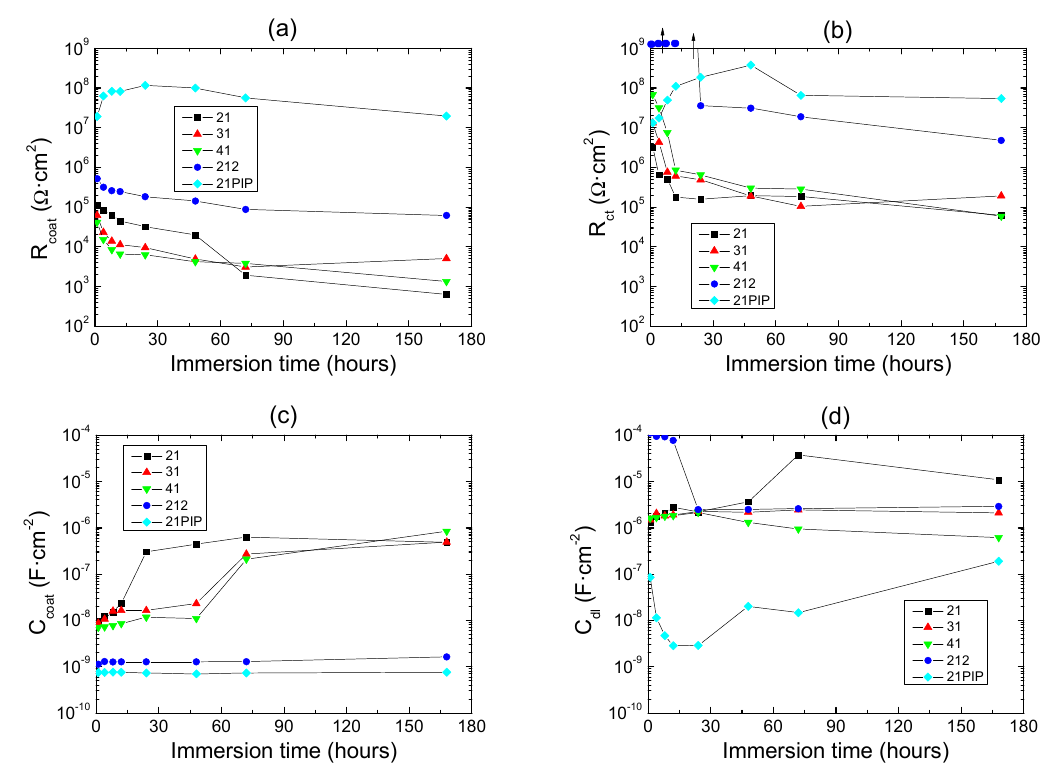
Figure 15. Evolution of the electrical element values of the proposed equivalent circuit during immersion tests: ( a ) R coat , ( b ) C coat , ( c ) R ct and ( d ) Cdl. Samples: 21, 31, 41, 212 and 21PIP. Test electrolyte: 0.05 M NaCl solution.